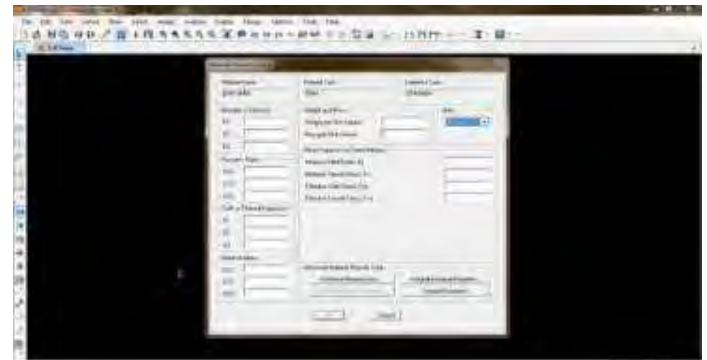
Figure 15. Material Property interface in SAP2000 (Author’s own, n.d.)